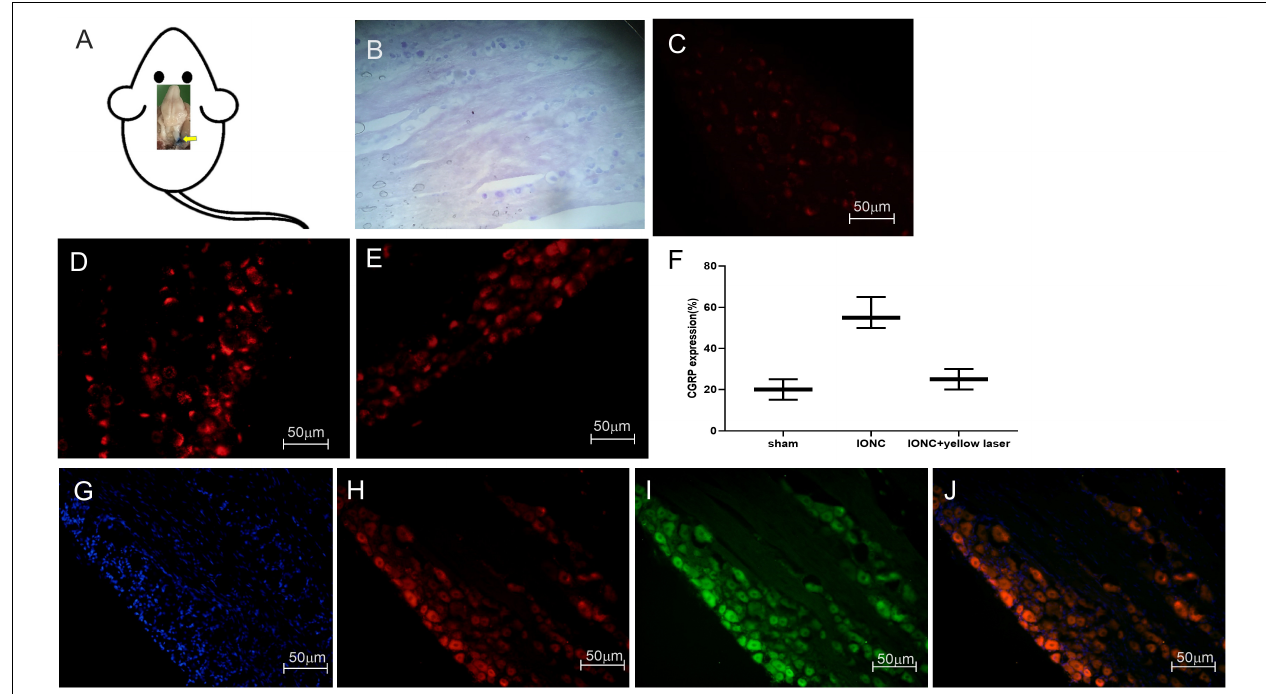
FIGURE 5 | Stereotaxic injection tracking, optogenetic virus colocalization and CGRP expression in TG. (A) Tracking of the target site (trigeminal ganglion) with Evans blue dye after stereotaxic injection following sacrifice. (B) Cresyl violet staining of the trigeminal ganglion. When compared to a sham control (C) , immunofluorescence images demonstrate a significant increase in CGRP expression afterIONC (D) . (E) Decreased CGRP expression following optogenetic inhibition in TG neurons with yellow laser stimulation. (F) Quantified CGRP expression of immunofluorescent images in different conditions ( n = 3 in each group). (G) DAPI, (H) mCherry, (I) EYFP, (J) merged images for colocalization of optogenetic virus (NpHR and ChR2) expression in TG neurons.Sample size in each group = 3. Scale = 50 µ m.